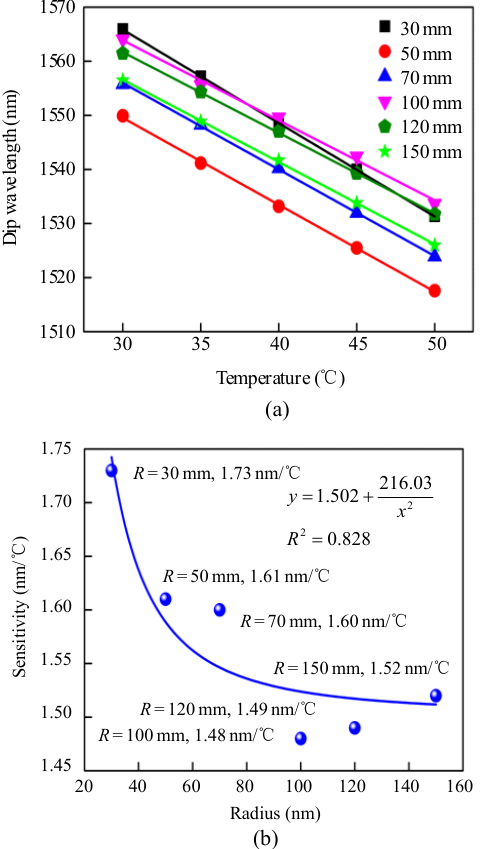
Fig. 7 PMF based-Sagnac interferometer of the PMF length is 150 mm with (a) the different circle radii dependence on temperature response (b) and the different temperature sensitivity distribution on different circle